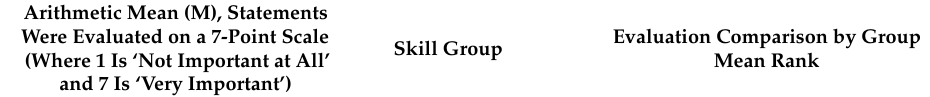
Table 2. Evaluation of the importance of critical thinking skills in the modern labour mar- ket/evaluation comparison by